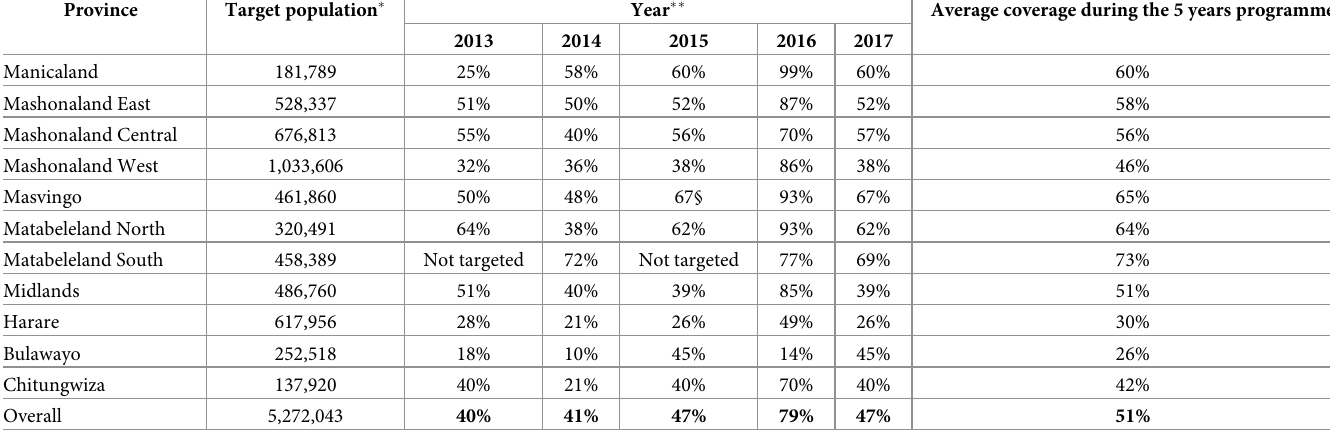
Table 2. Coverage of deworming of school-age children in Zimbabwe by province and by